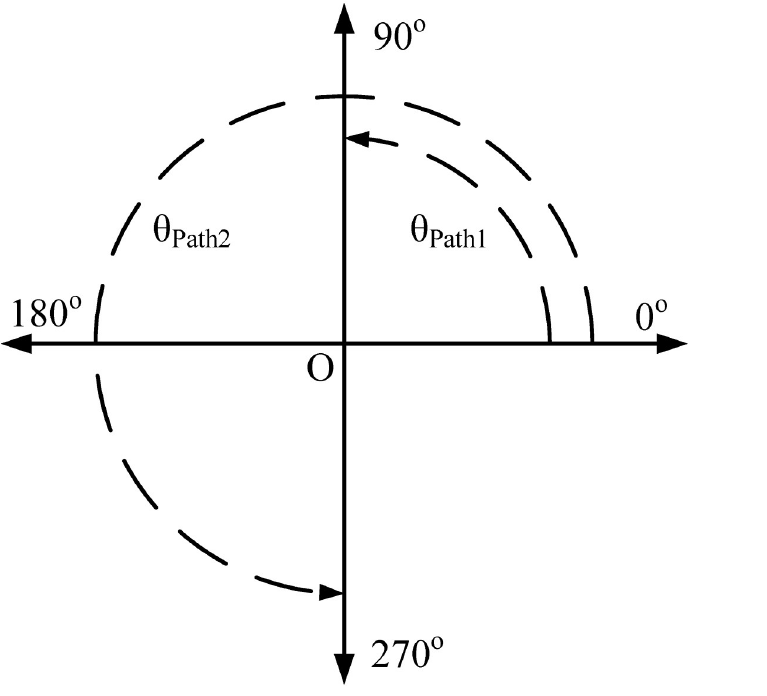
Fig 2. Coordinate system representantion for proposed